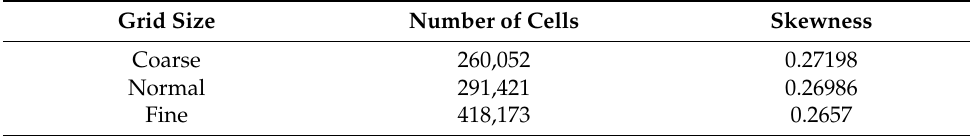
Figure 3. Three types of mesh slurry pump: ( a ) fine mesh; ( b ) normal mesh; ( c ) coarse mesh. Table 1. The number of cells with different grid types in the slurry